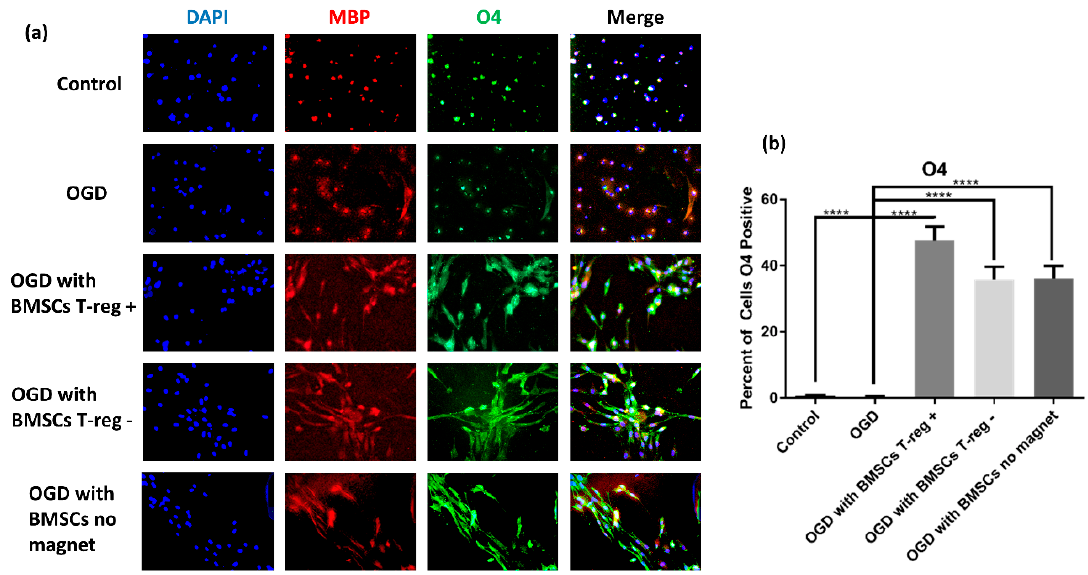
Figure 3. OPCs co-cultured with BMSCs showed increased expression of intermediate oligodendrocyte marker O4 compared to control. ( a ) Fluorescently labeled cell nuclei with DAPI, oligodendrocyte progenitor cell (OPC) myelin processes labeled with myelin basic protein, OPC O4 expression labeled with oligo O4, and merge. ( b ) Quantification of MBP+ cell count in each group shown as percent of cells expressing O4 per image, mean ± SEM.